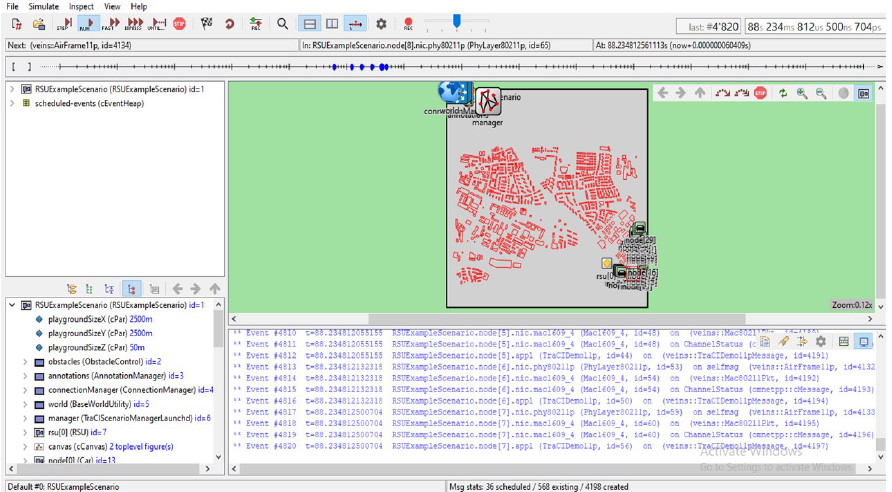
Figure 12. OMnet++ view.